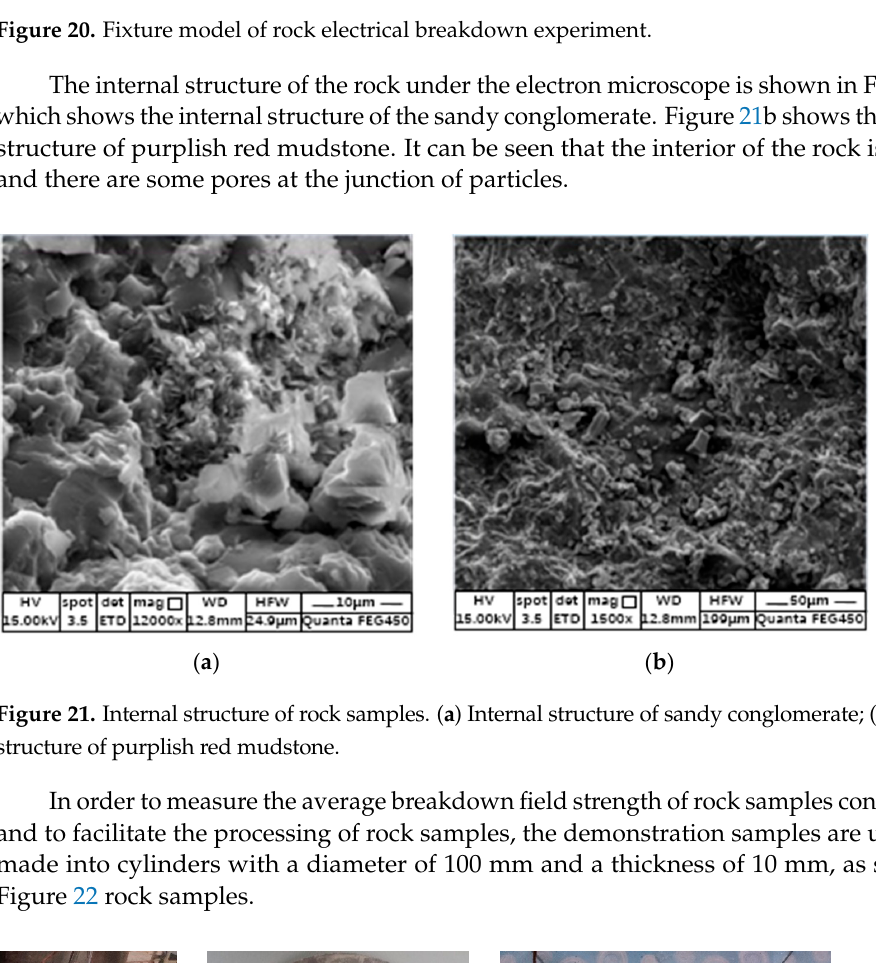
Figure 20. Fixture model of rock electrical breakdown experiment.